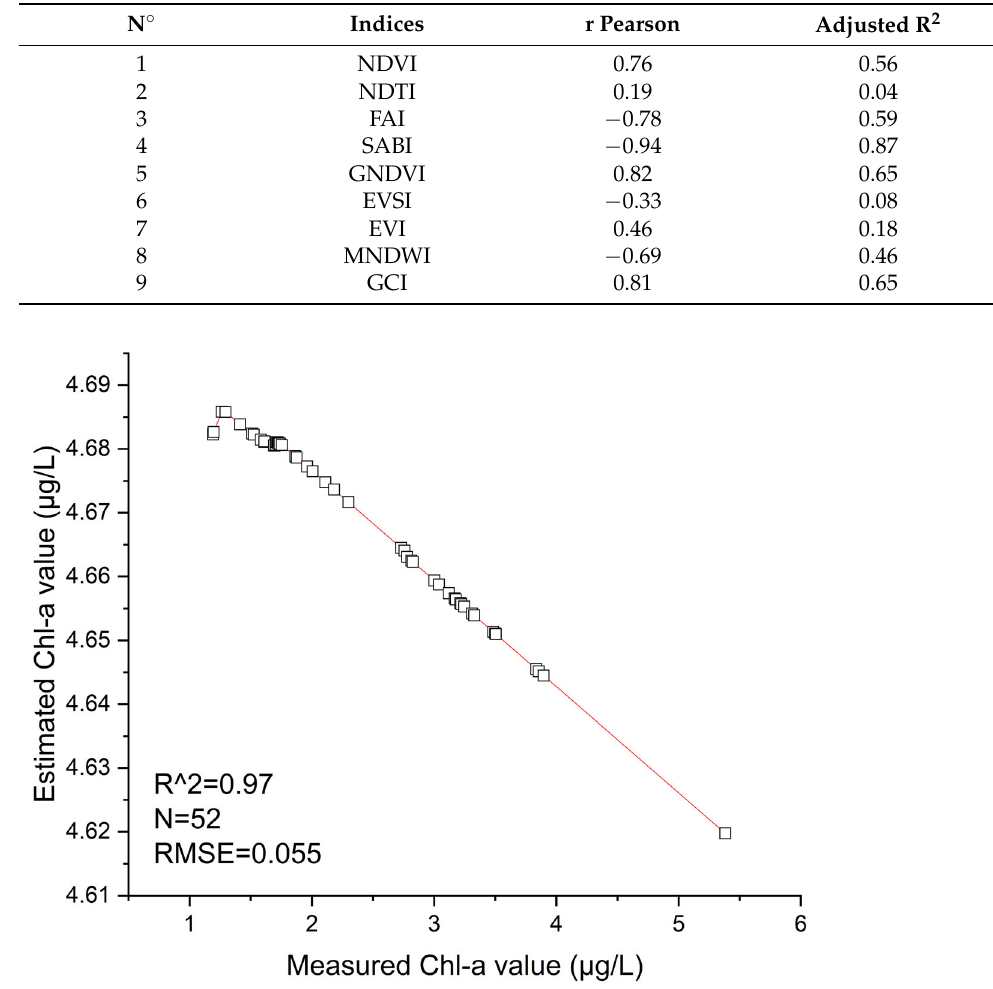
Figure 2. Measured Chl-a and Chl-a estimated using the obtained multiple linear regression model.